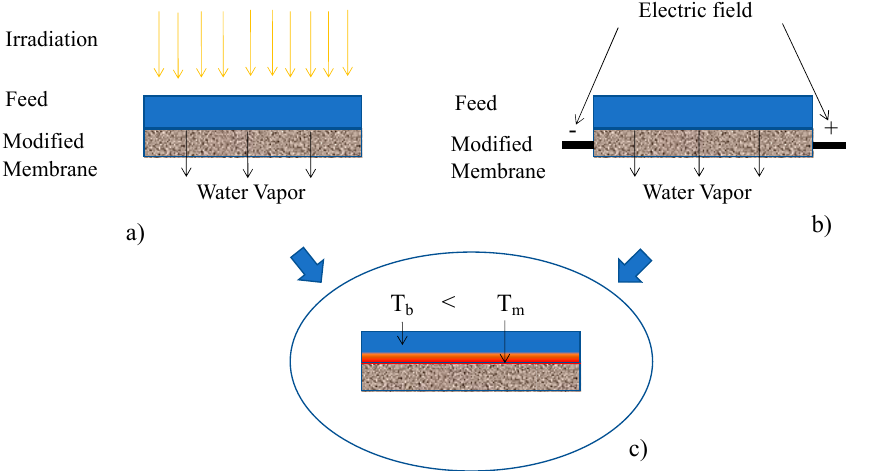
Figure 2. Modified membranes under ( a ) irradiation, ( b ) electrical field, and ( c ) temperature difference at the feed side.